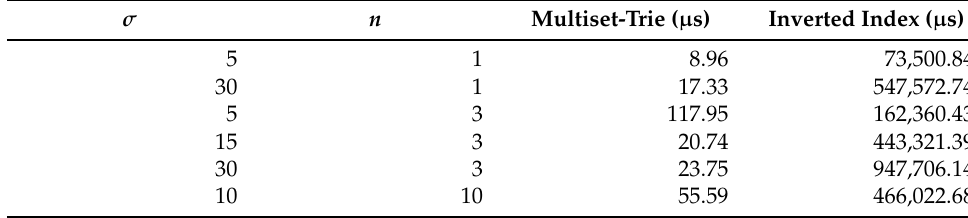
Table 3. Sub-multiset search.